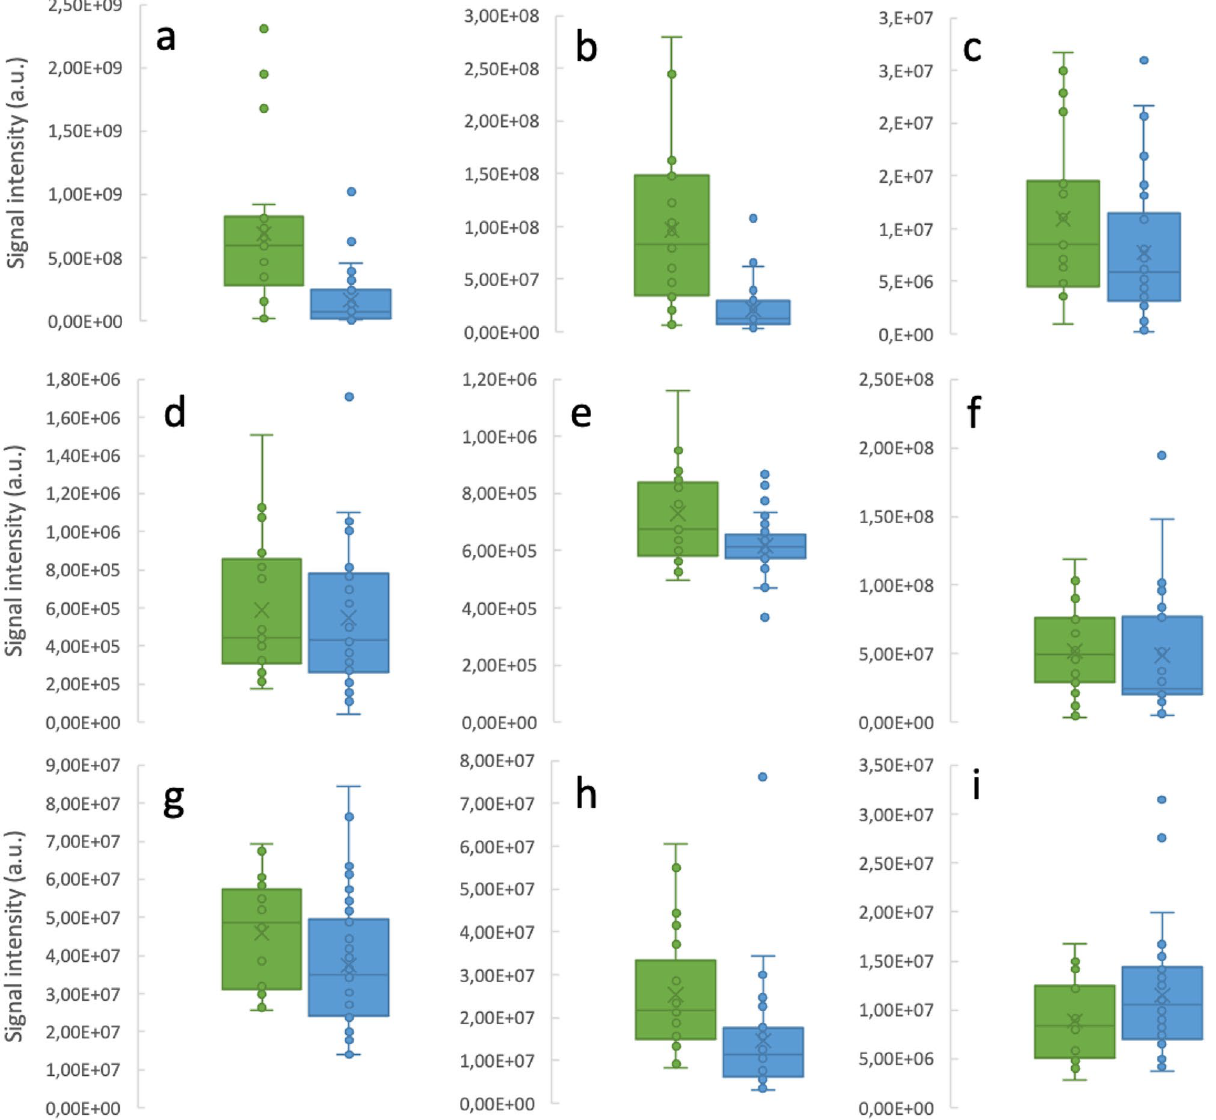
N-acetylglucosamine ( c ), glutamic acid ( d ), isovaleric acid ( e ), octan-3-one ( f ), fructose ( g ), serine ( h ) and dopamine ( i